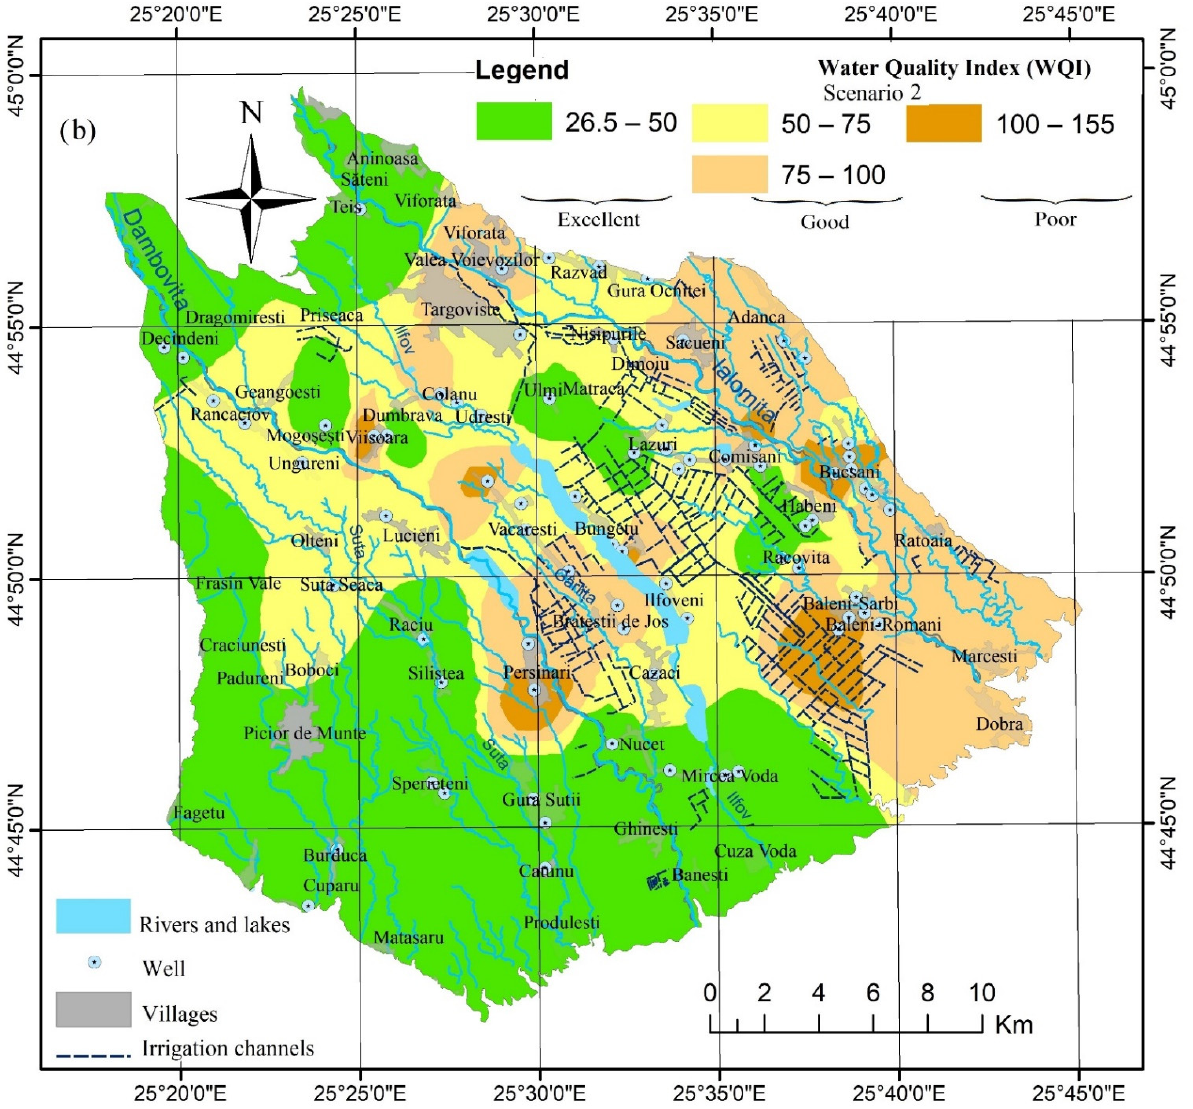
Figure 4. Maps of the Water Quality Index (WQI) in Târgovi ş te Plain in Scenario 1 ( a ) and Scenario 2 ( b ).